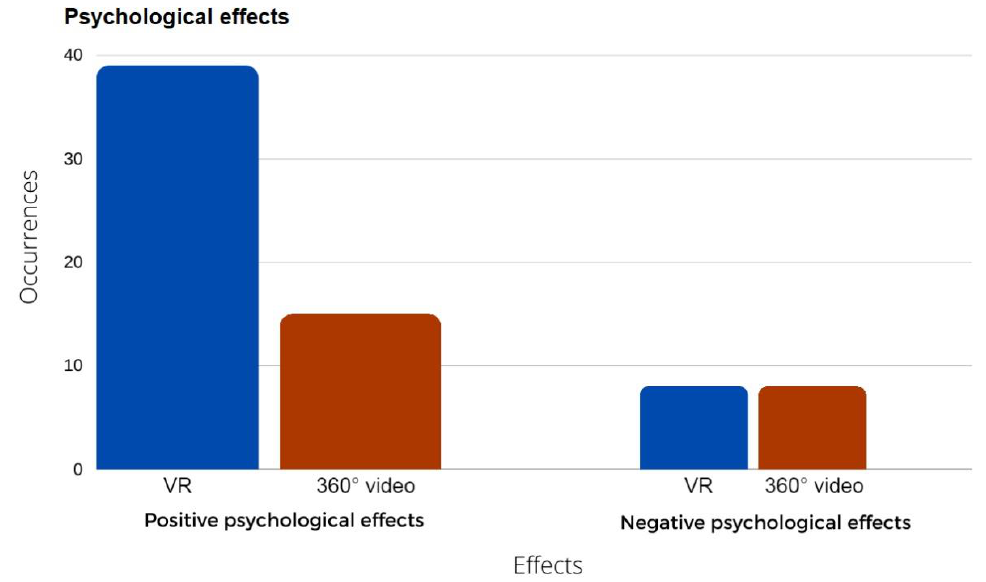
Figure 4. Positive and negative psychological effects occurrences on VR and 360° videos for older people.